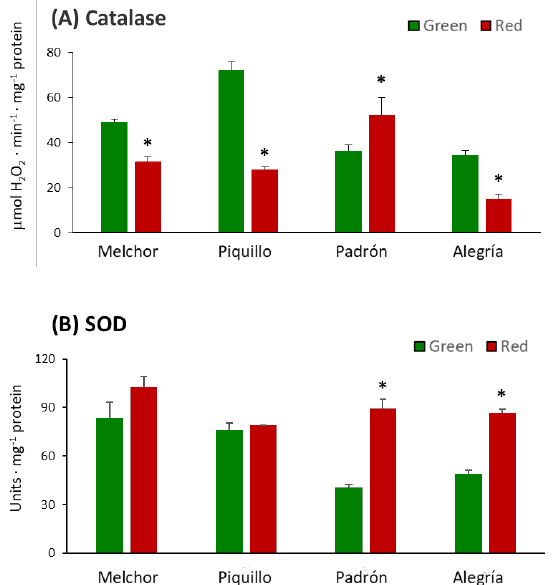
Figure 4. Catalase and superoxide dismutase (SOD) activity in pericarp from fruits of four pepper varieties at two ripening stages. ( A ), catalase. ( B ), SOD. Data are the means ± SEM of three